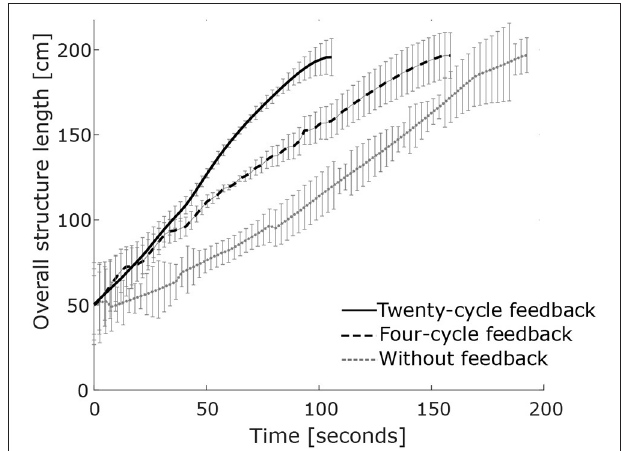
FIGURE 10 | Comparison of deployment trajectories for twenty tests without feedback, four-cycle feedback, and twenty-cycle feedback. Two standard deviations of end-node position error are